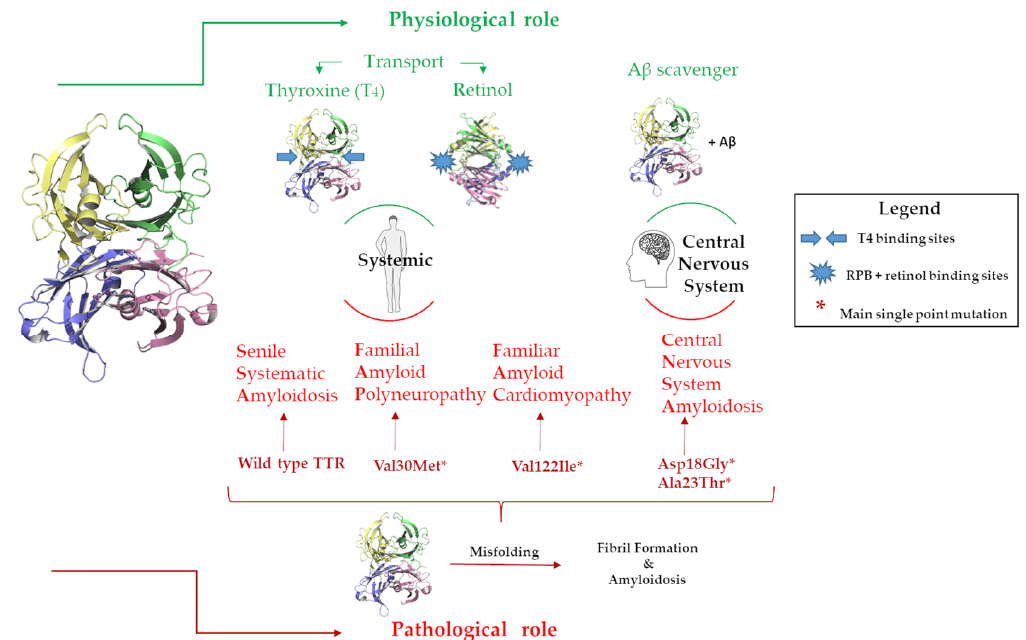
Figure 2. Graphic representation of the TTRs physiological and pathological roles in the body and in the CNS.